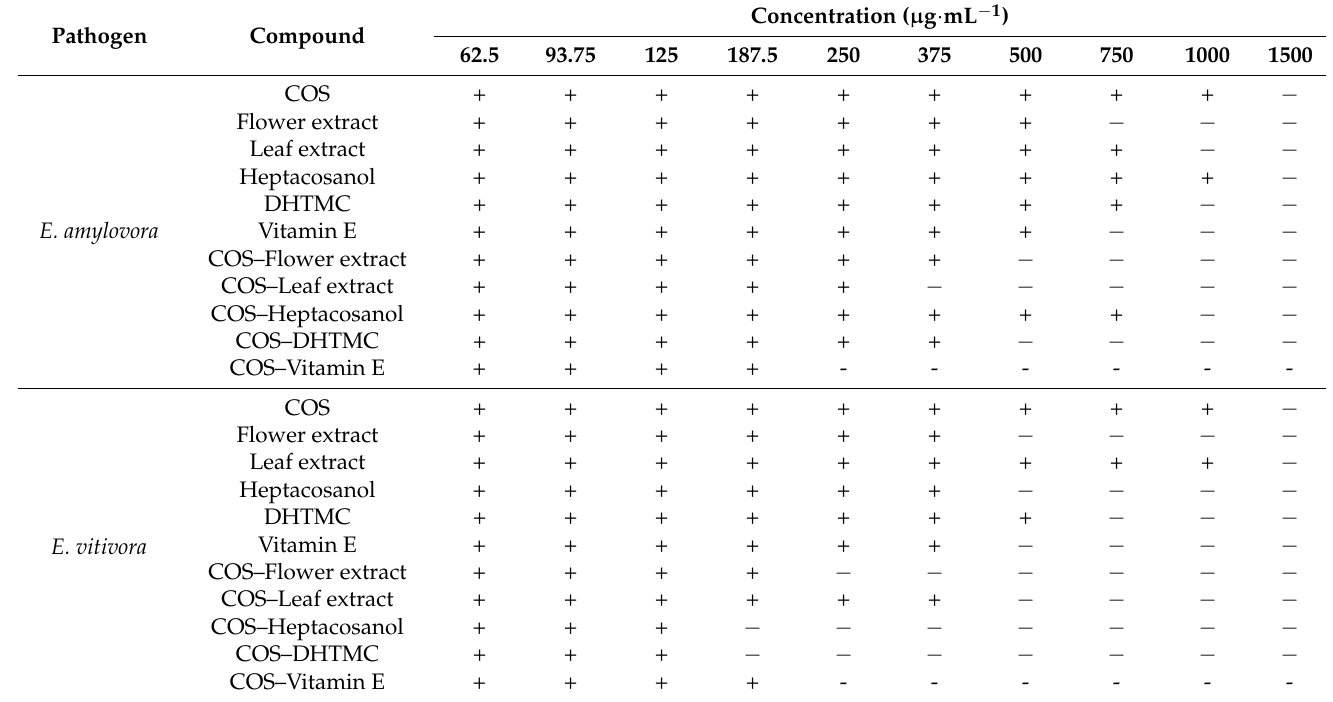
Table 5. Antibacterial activity of chitosan oligomers (COS), H. syriacus flower and leaf hydromethanolic extracts, their main constituents (heptacosanol, DHTMC, and vitamin E), and their corresponding conjugate complexes (COS–flower extract, COS–leaf extract, COS–heptacosanol, COS–DHTMC, and COS–vitamin E) against the two phytopathogenic bacteria under study at different concentrations (expressed in µ g · mL − 1